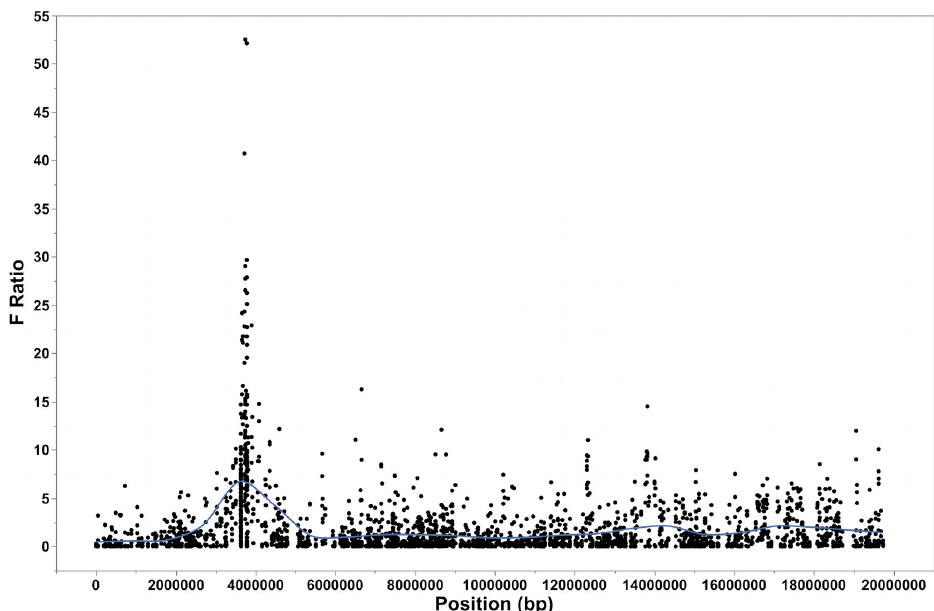
Fig 3. Association results between the genotypes of the DNA polymorphisms mapped to the 19 Mb scaffold of the proximal end of SSC12 and PCV2b viral load using a linear mixed additive model. The line represents a smoother with a default λ of 0.05. SYNGR2 p . Arg63Cys and BIRC5 g . -343delA were associated with the largest effects on PCV2b viral load (F-ratio > 47, P <